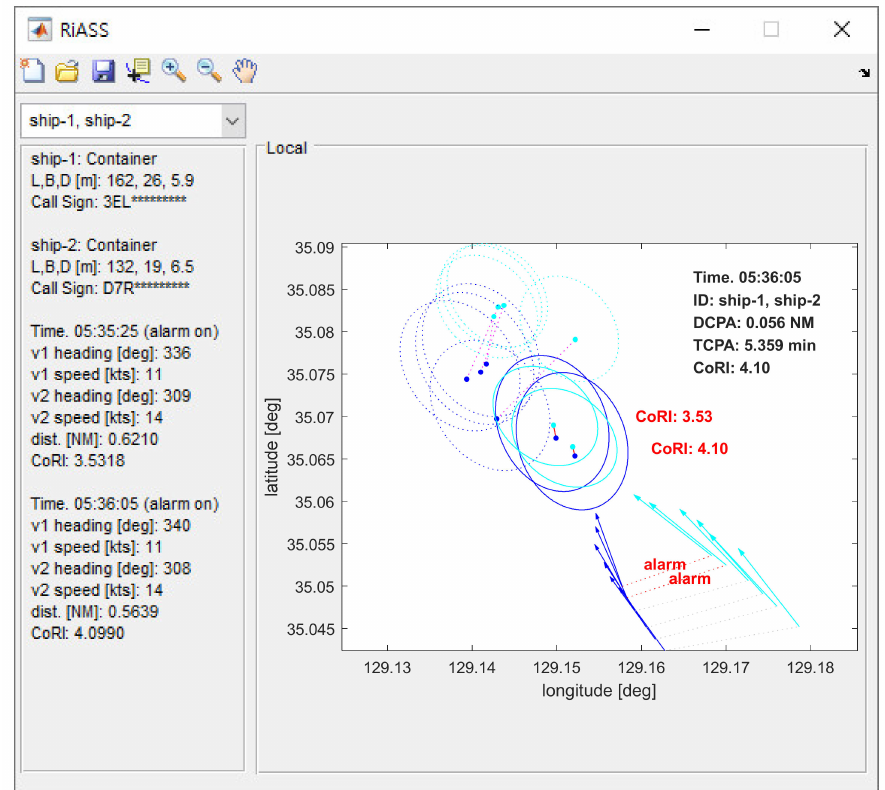
Figure 8. Collision risk assessment support system (RiASS)